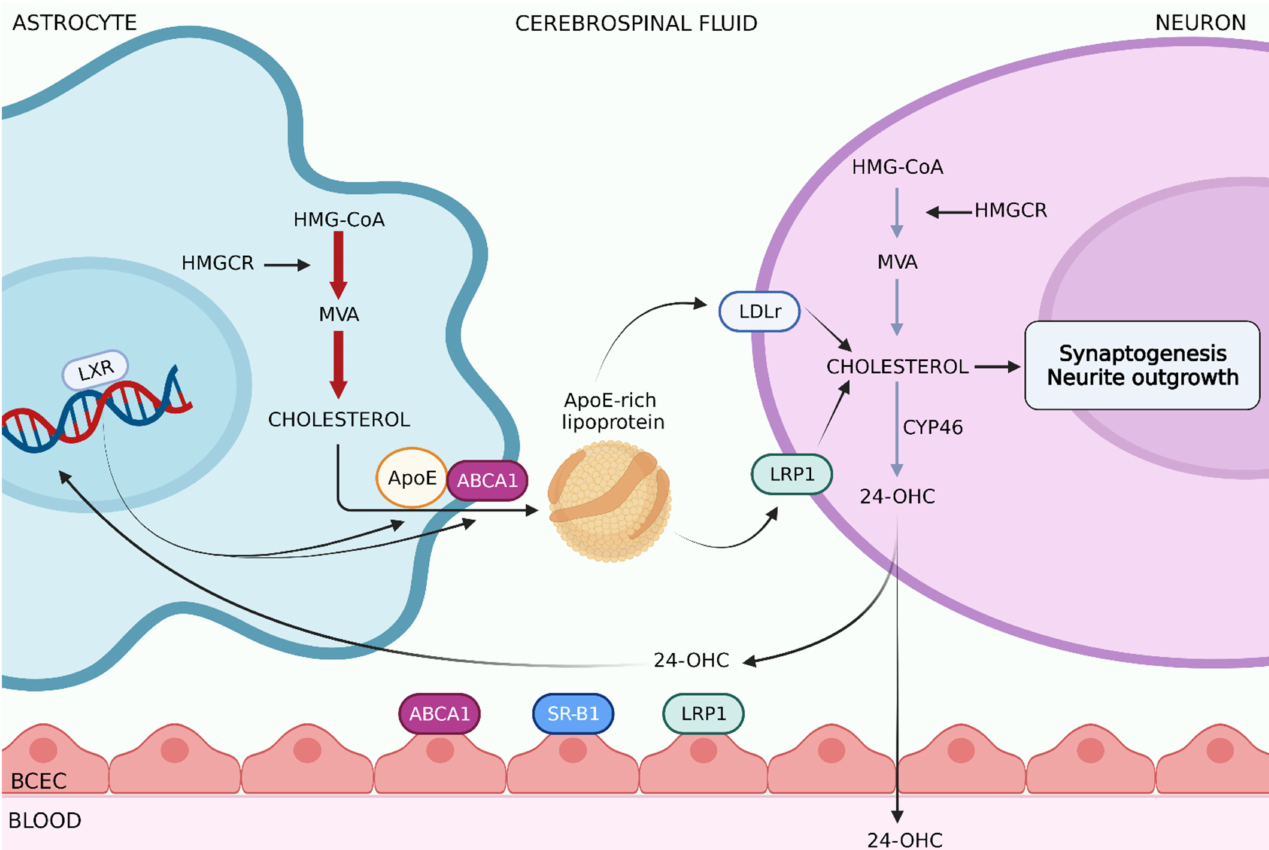
Figure 2. Cholesterol metabolism in the CNS. Cholesterol in the brain is assured by de novo biosynthesis requiring a multistep pathway. HMGCR is responsible for the conversion of HMG-CoA in MVA and represents the key and rate- limiting step. In the adult CNS, neurons reduce their own cholesterol synthesis and import this lipid from astrocytes, which secrete apoE rich-lipoproteins through ABCA1 transporters. ABCA1 and apoE transcription is elicited by LXR, whose activity is modulated by 24-OHC. Cholesterol uptake in neurons is ensured by LDLr and LRP1, particularly expressed on the cell membranes of neurons. Cholesterol excretion in the brain is mainly promoted by its conversion to 24-OHC catalyzed by CYP46. Abbreviations: 24-OHC, 24(S)-hydroxycholesterol; ABCA1, ATP-binding cassette transporter A1; apoE, apolipoprotein E; BCEC, brain capillary endothelial cells; CYP46, cholesterol 24-hydroxylase; HMGCR, 3-hydroxy-3- methylglutaryl-CoA reductase; LDLR, LDL receptor; LRP1, LDLr-related protein 1; LXR, liver X receptor; MVA, mevalonate; SR-B1, scavenger receptor class B member 1. This figure is created with